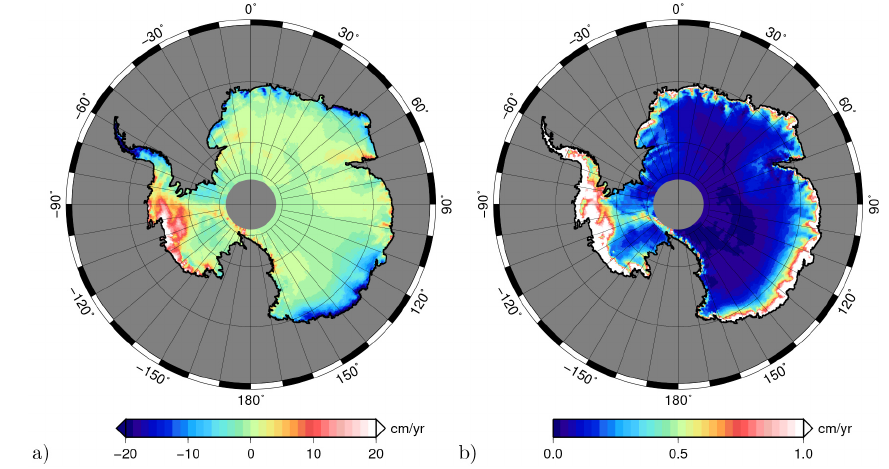
Fig. 6. (a) Firn densification model (FDM) surface height velocities and (b) corresponding uncertainties.